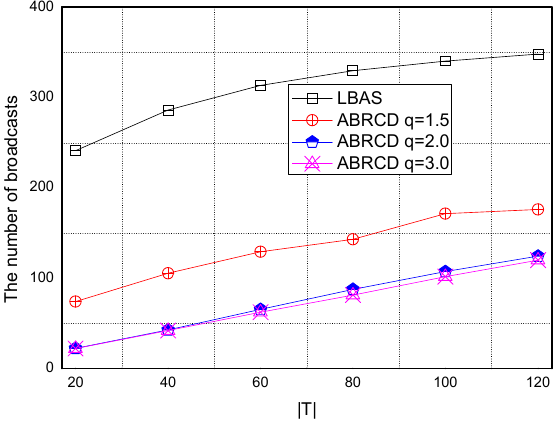
Figure 28. The impact of | T | and q with fixed network size = 400 on broadcasts.